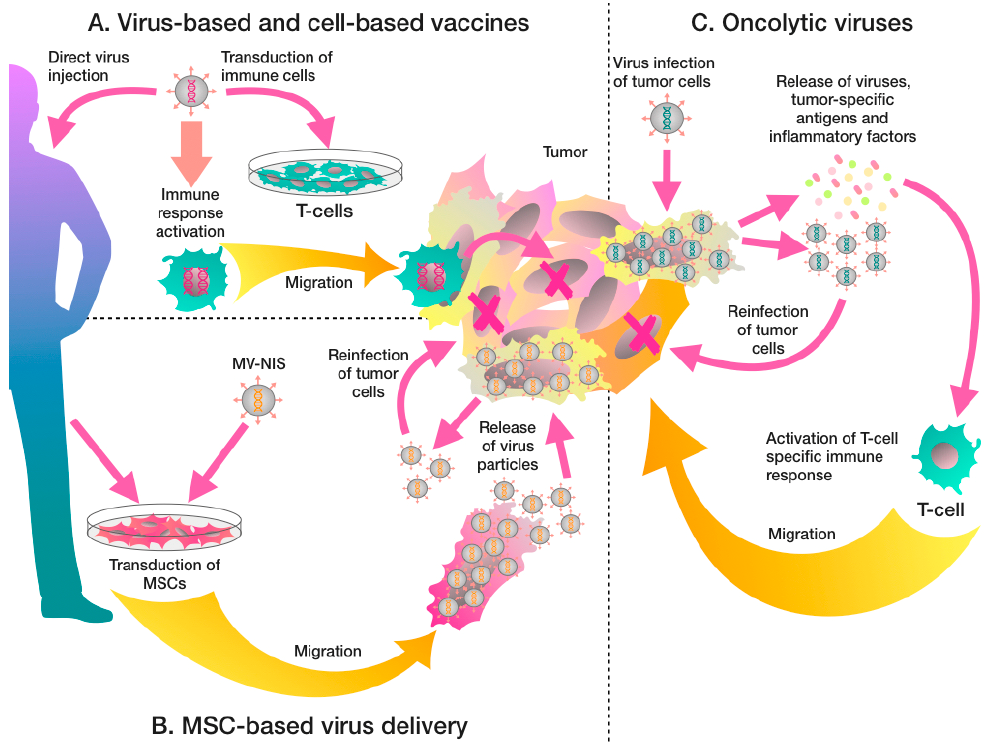
Figure 1. Recombinant virus based treatment of cancer. ( A ) Antitumor therapeutic vaccines, which are based on viruses encoding tumor-specific antigens, boost anti-cancer immune responses by enhanced presentation of the tumor antigens to immune cells. Another promising approach is the use of immune cell-based vaccines to stimulate antitumor immunity. In this case, T-cells are genetically engineered to express tumor-specific antigen receptors to improve recognition of cancer cells, for example CARs. ( B ) Therapeutic viruses, for example MV-NIS (the Edmonston strain of measles virus), can also be delivered to the tumor with mesenchymal stem cells (MSCs), which have a natural tropism toward tumor niches. ( C ) Oncolytic viruses preferentially infect tumor cells and induce tumor cell death. Additional genetic modification with immunomodulating genes such as granulocyte-macrophage colony-stimulating factor ( GM-CSF ), can enhance anti-tumor effect. Oncolytic viruses also cause local inflammation, which manifests as increased infiltration of immune cells into the tumor, local release of interferons (IFNs), chemokines, danger-associated molecular patterns (DAMPs), pathogen-associated molecular patterns (PAMPs) and mediate a tumor-specific immune